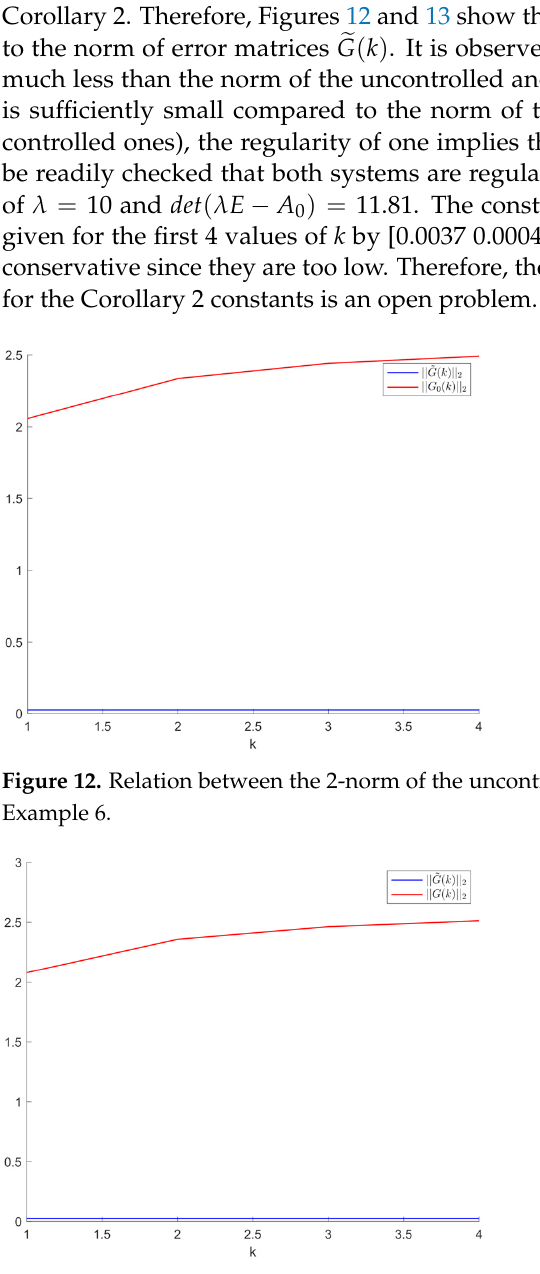
Figure 13. Relation between the 2-norm of the controlled matrix G ( k ) and error matrix (cid:101) G ( k ) in Example